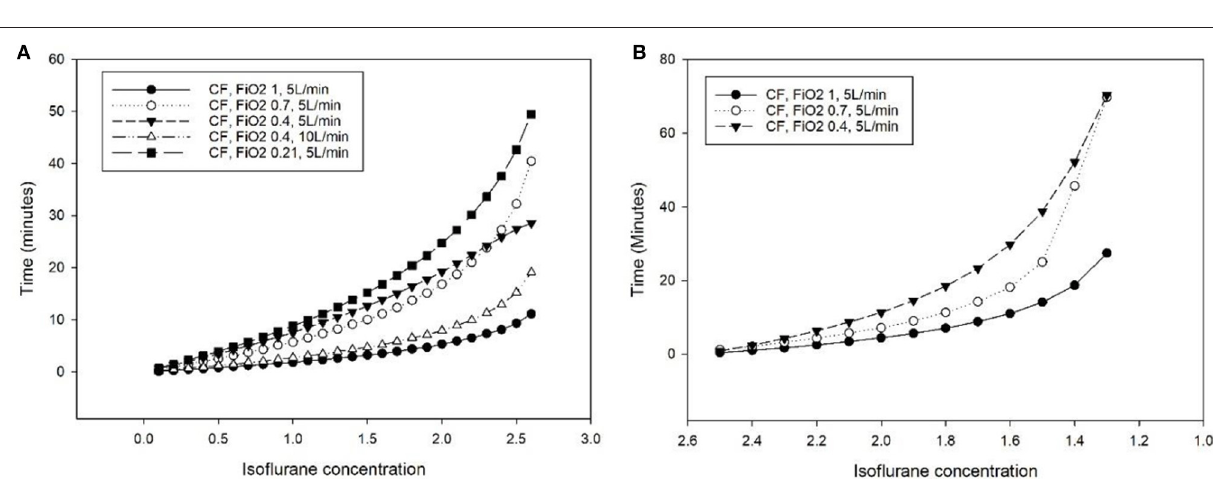
Step 1d Changes in F i O 2 had no effect on the steady isoflurane partial pressure in the breathing